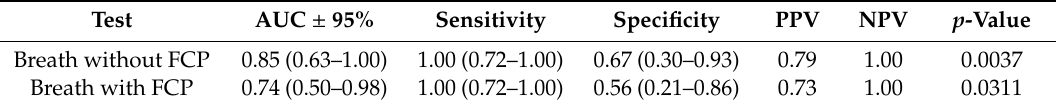
Table 8. CD vs. UC (without and with FCP): Wolf eNose results.